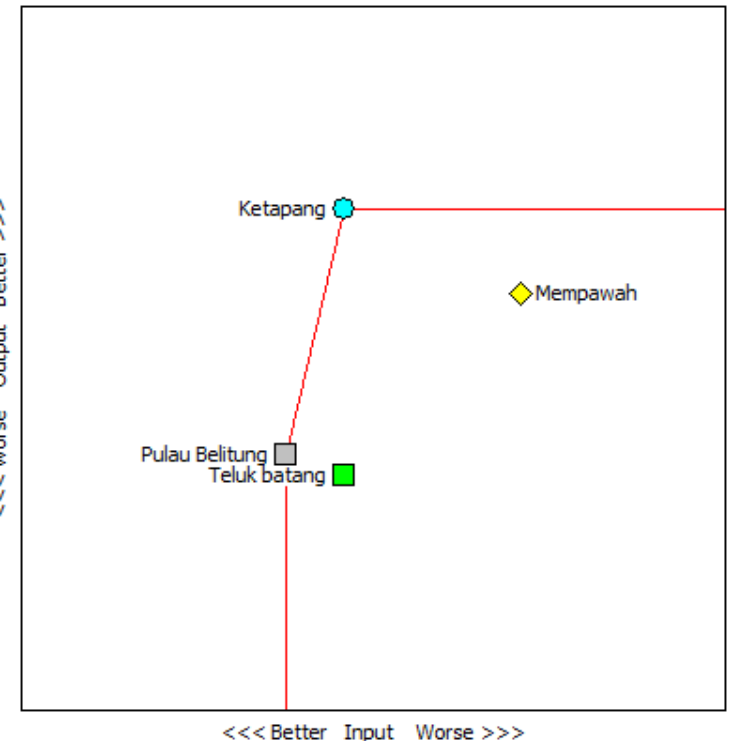
Figure 8. Efficient frontier using the social aspect (input) and environmental aspect (output).